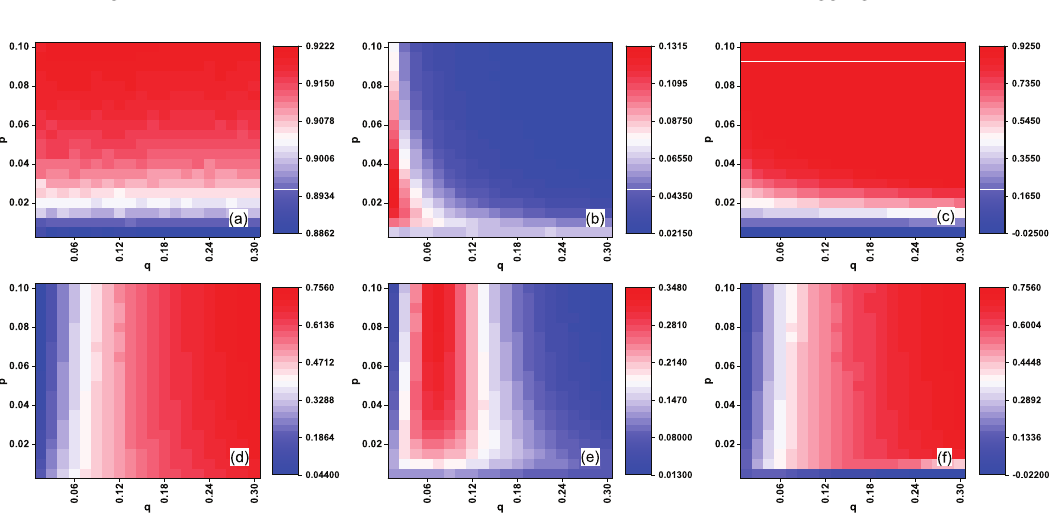
AUC values and recall of the EigenRank algorithm are larger than their counterparts in the IBeta method and Vote Aggregation method with different pair ( p , q ) under the random/mali- cious rating attack case. For example, AUC = 0.908, Δ AUC = 0.144 (compared to Vote Aggre- e e gation method) and R ( L ) = 0.724, Δ R ( L ) = 0.274 (compared to Vote Aggregation method) c c